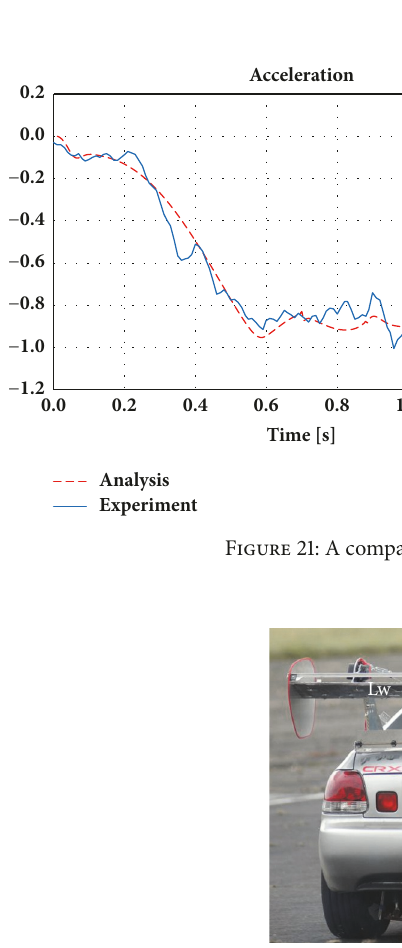
Figure 20: (a) Starting point for braking analysis. Car body colored with static pressure and iso-surface of Q-Criterion colored with velocity magnitude. (b) Initial CFD results for cornering analysis. Streamlines colored with velocity magnitude (upper) and static.